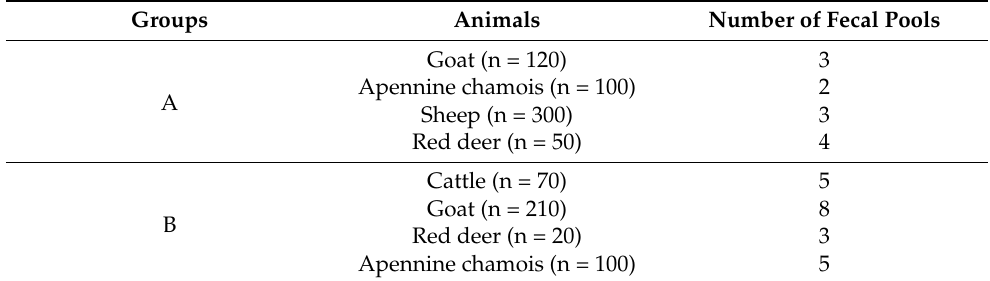
Table 1. Number of fecal pools obtained from each species of sympatric (A) and non-sympatric (B) groups.